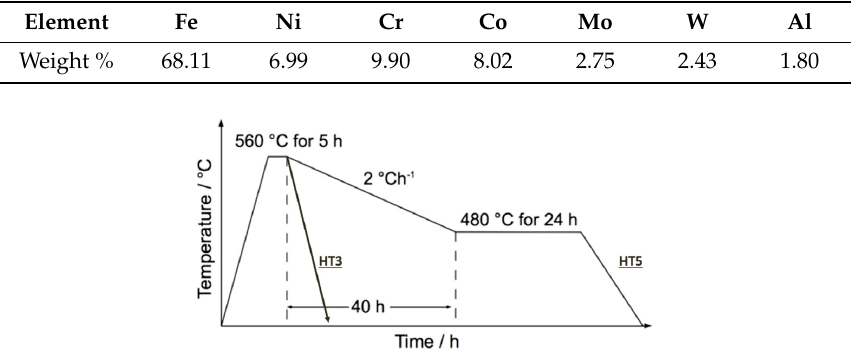
Table 1. The chemical composition of the maraging steel.